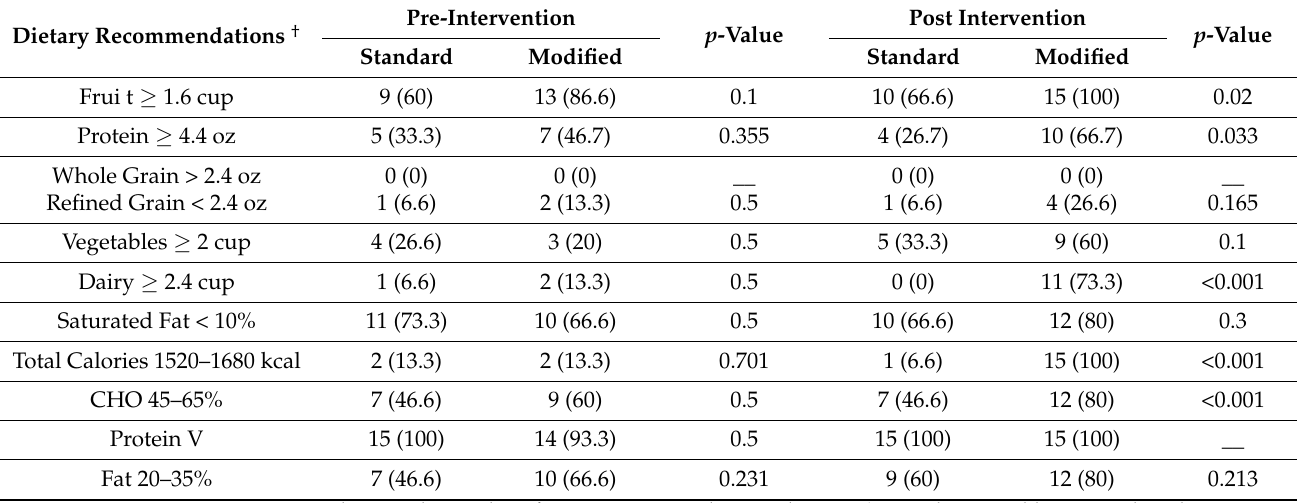
Table 2 describes the food groups and the nutrient content of the meal plans prepared by the participants in the standard and modified groups before and after the training session. Food types were divided into seven categories as per the American Dietary Guidelines’ classification of food items. The last three rows represent the Acceptable Macronutrient Distribution Range (AMDR) values, as recommended by the Academy of Nutrition and Dietetics. The table provides information on the number and percentage of the participants who met their daily dietary needs from each food category within each group. Table 2. Nutrient composition among standard and modified exchange list groups in the pre-and